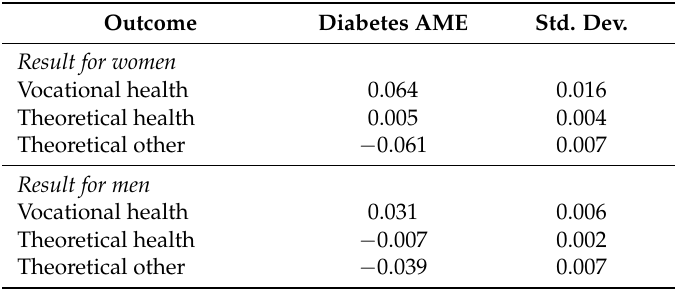
Table A2. Average marginal effects (AME) by nested logit estimation of the probability of field of upper secondary education using vocational other as the reference category. Estimations control for year of birth and own and parental